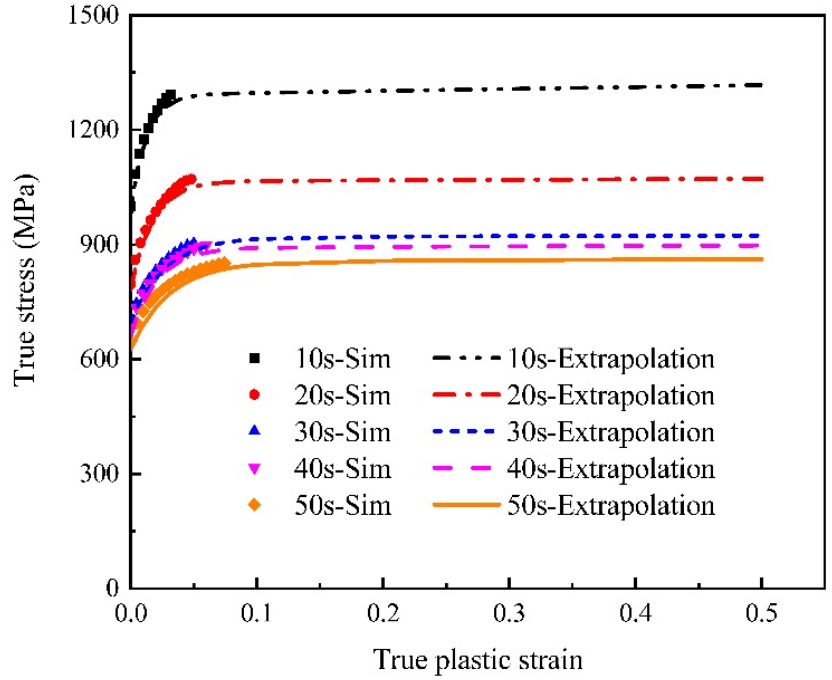
Figure 10. Flow stress curves of extrapolation for different holding times (the dots represent simulated values in RVE and the lines represent extrapolation values).